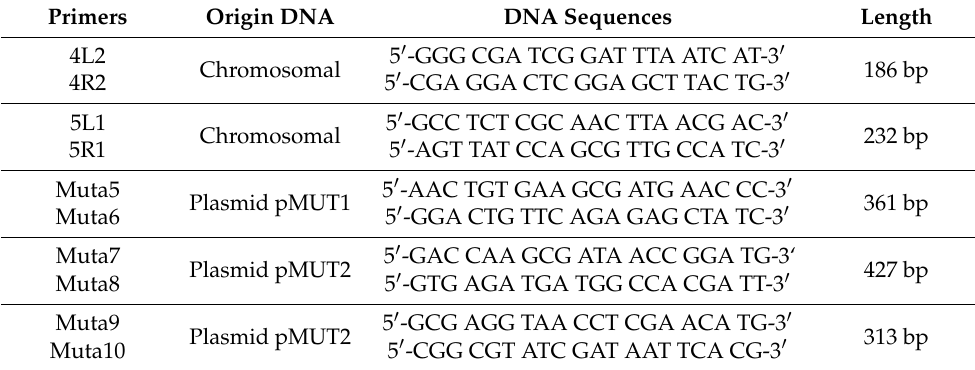
Table 2. List of PCR primers